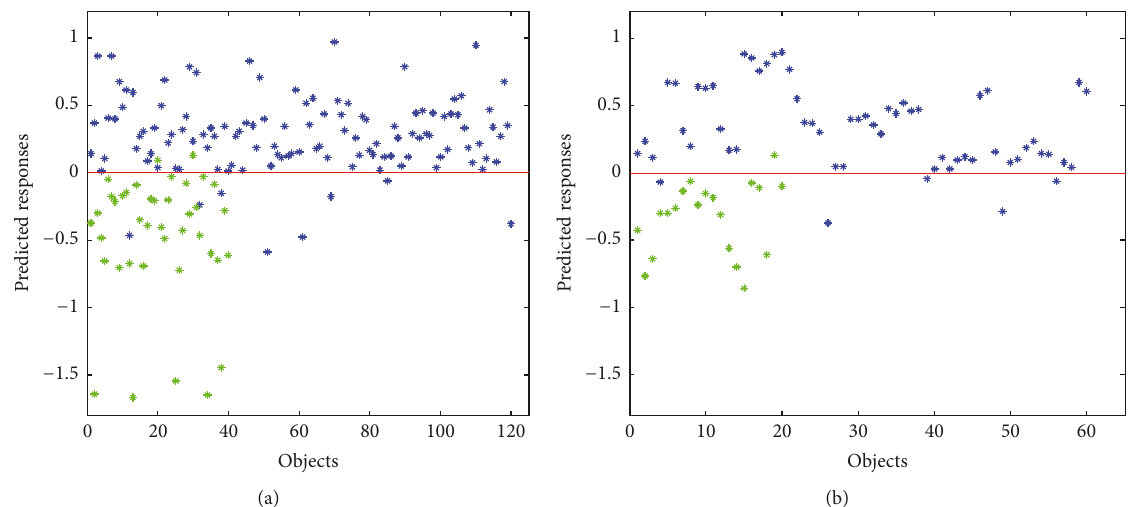
Figure 3: Training (a) and predicting (b) results of PLSDA model based on the data of electronic tongue. The AWT objects were marked by blue asterisks and the NAWT objects were denoted by green